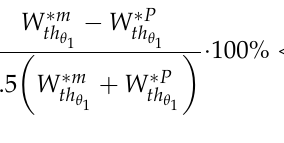
Figure 10. The ∂ Q e vs. the pressure difference, ∆ p , for a positive displacement pump and (cid:3105)(cid:3018) (cid:3280) ∂ n Figure 10. The vs. the pressure difference, Δ p , for a positive displacement pump and motor. (cid:3105)(cid:3041)